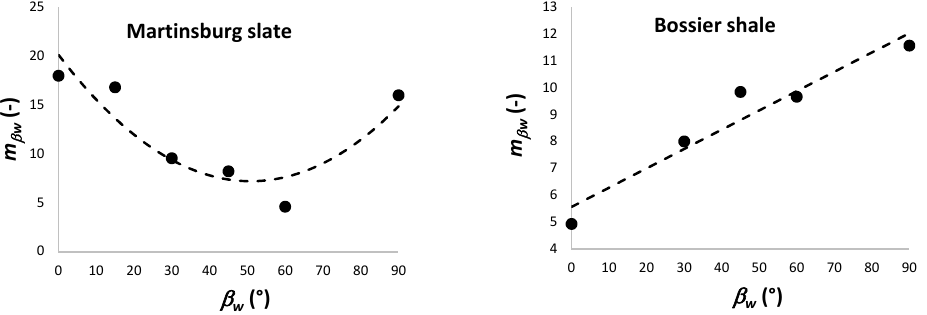
Figure 6. Values of m β w calculated from the linear regression of the triaxial test data (solid circles). The dotted lines represent the interpolating functions.